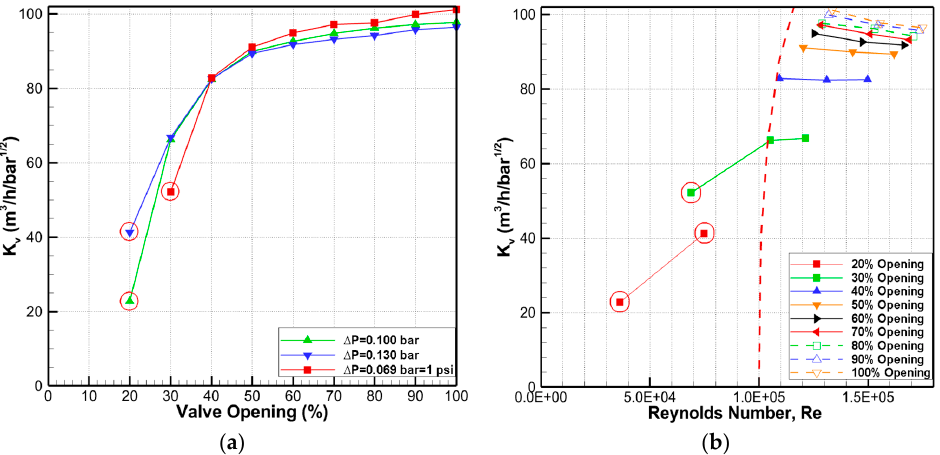
Figure 10. Comparison of the inherent and installed characteristics.